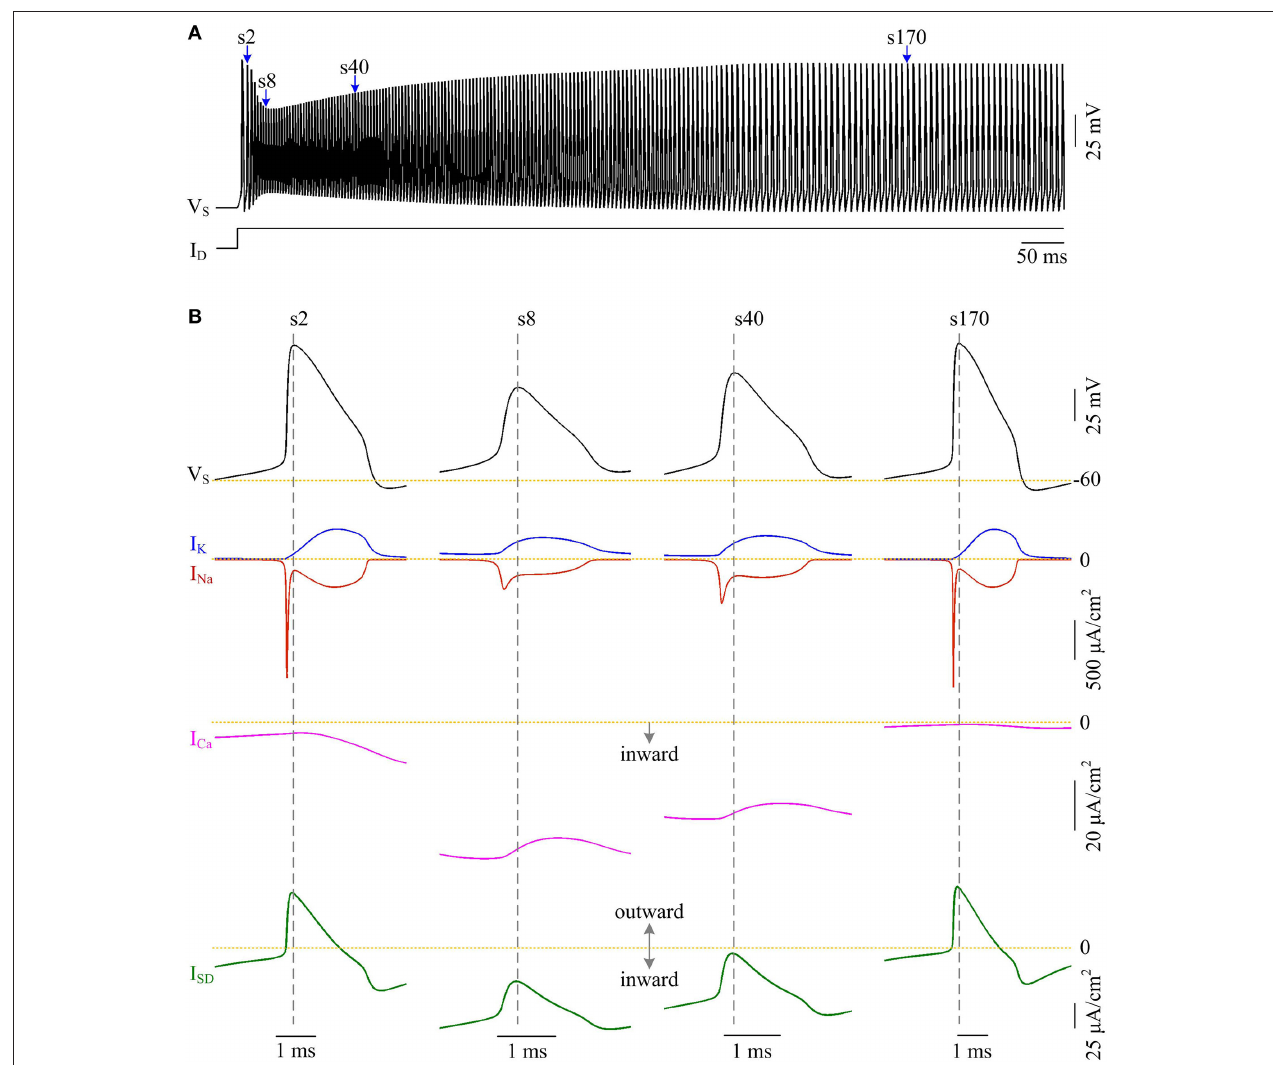
FIGURE 8 | Activating I Ca makes the overlap between I SD and I Na disappear and increases AP efficiency. (A) Spike train recorded in the model II neuron with p = 0.4. We extract four APs indicated by blue arrows to examine their underlying currents. (B) I Na (red), I K (blue), I Ca (pink) and I SD (green) underlying the 2nd, 8th, 40th, and 170th APs. I D = 5 µ A / cm 2 and g c = 0.3 mS / cm 2